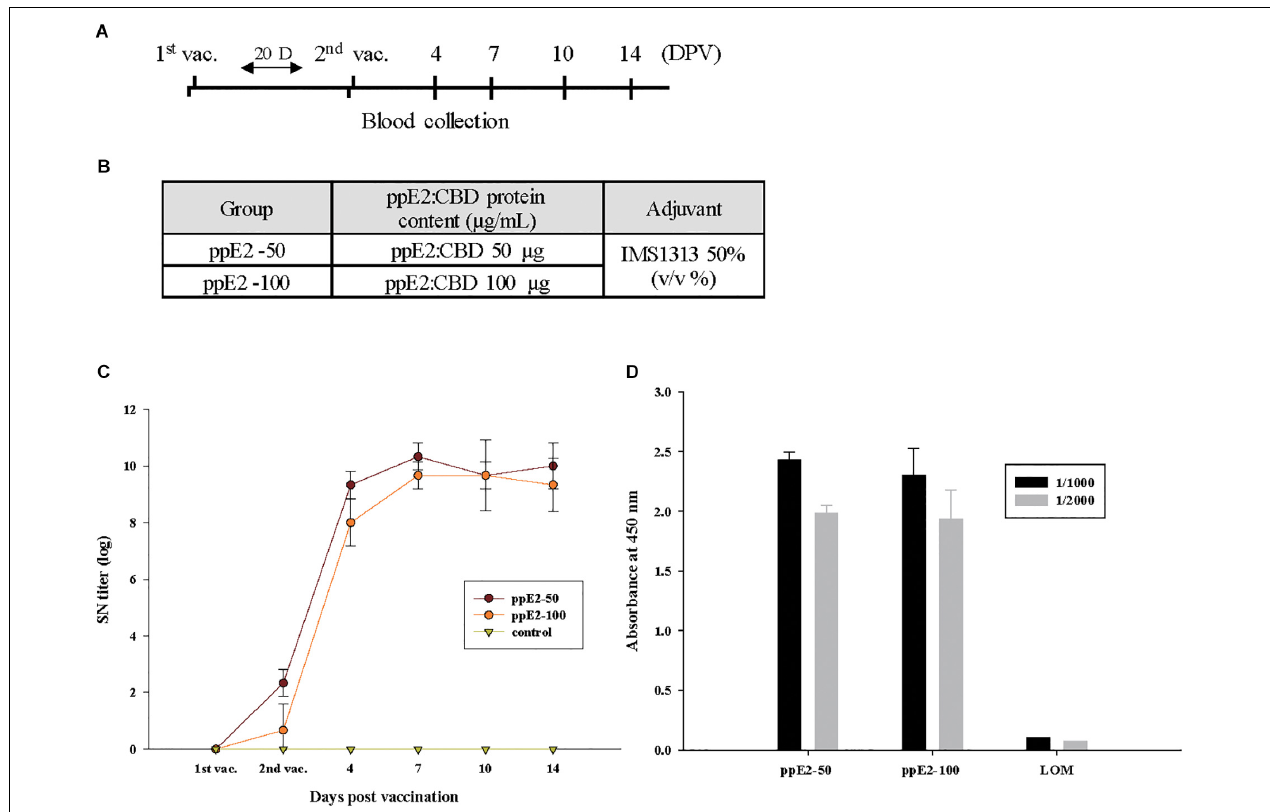
FIGURE 5 | ppE2 is highly immunogenic and induces production of antibody against E2 in piglets. (A) Schematic presentation of the two-dose immunization protocol. DPV, days post-vaccination. Blood was collected immediately before injection and at the indicated DPV. (B) Immunization of piglets. The piglets were injected twice with 50 µ g or 100 µ g of plant-produced E2 fusion protein (ppE2) in 50% IMS1313 used as an adjuvant. For each dose, three piglets were immunized. (C) E2-specific immune response, determined by ELISA. Serum samples collected from piglets vaccinated with ppE2 were analyzed for E2-specific immune responses by ELISA. Non-vaccinated piglets were included as negative control. Data are mean ± SEM for three pigs per group. (D) Cellulose-binding domain (CBD)-specific immune response, determined by ELISA. Serum samples collected from piglets vaccinated with ppE2 or LOM live vaccine were diluted by 1:1,000 or 1:2,000 and used to analyze CBD-specific immune responses by ELISA. Data are mean ± SEM for three pigs per group.